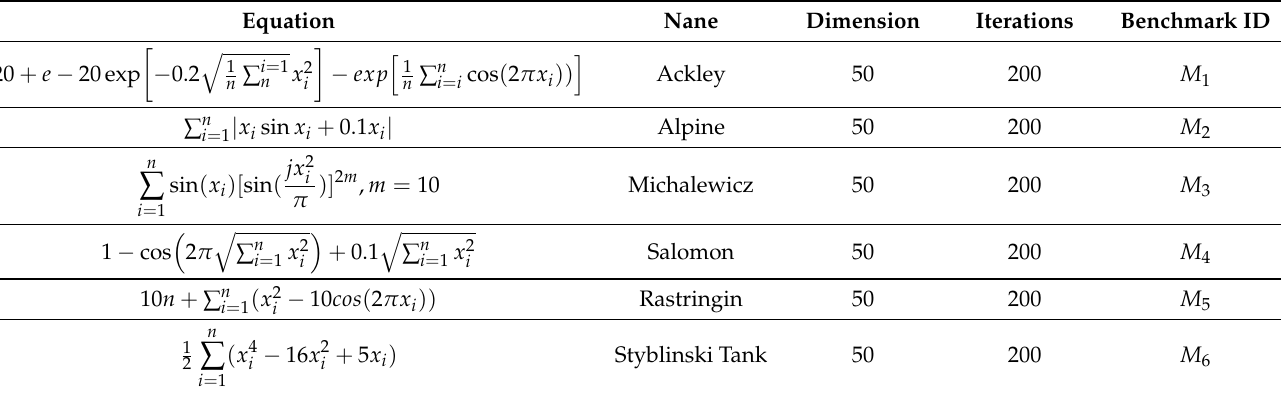
Table 6. Multimodal benchmark functions